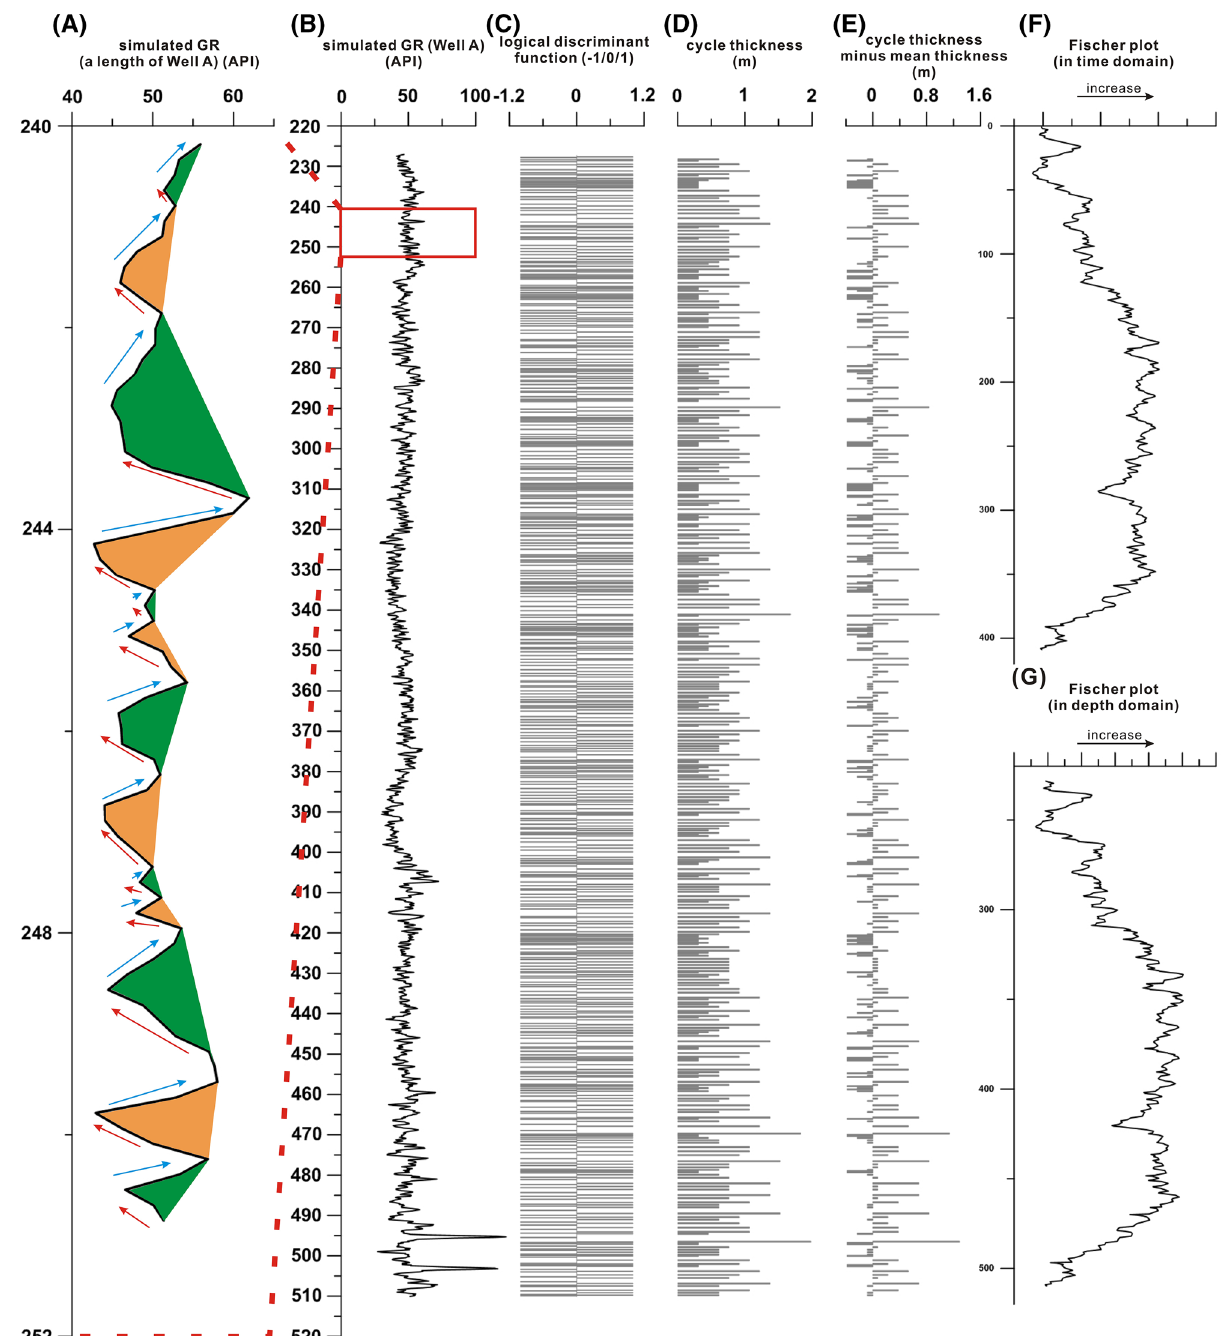
( B ). The processes of calculating number and thickness of sedimentary cycles ( C ), ( D ,) and ( E ). Fischer plots of the Well A in both the time and depth domains ( F ) and ( G